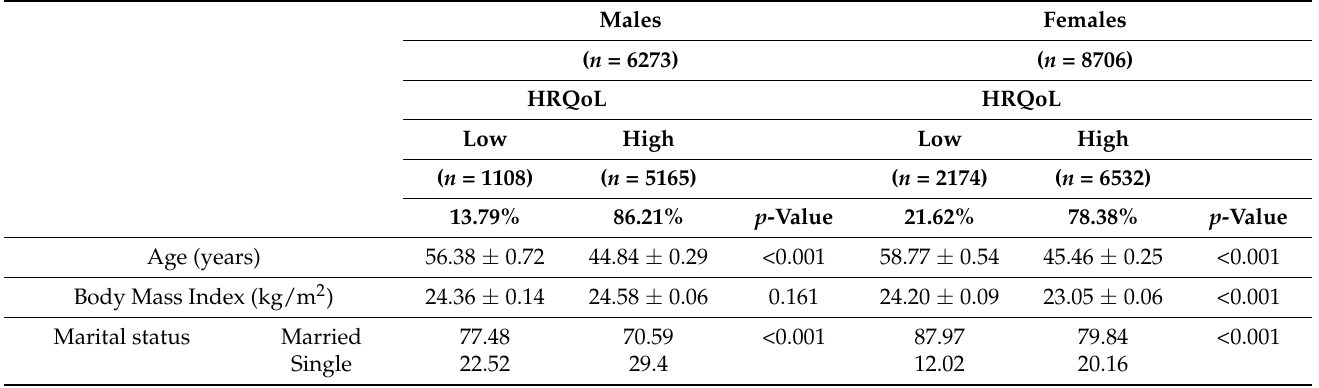
Table 1. Demographic characteristics according to the HRQoL stratified by sex among Korean adults ( n =